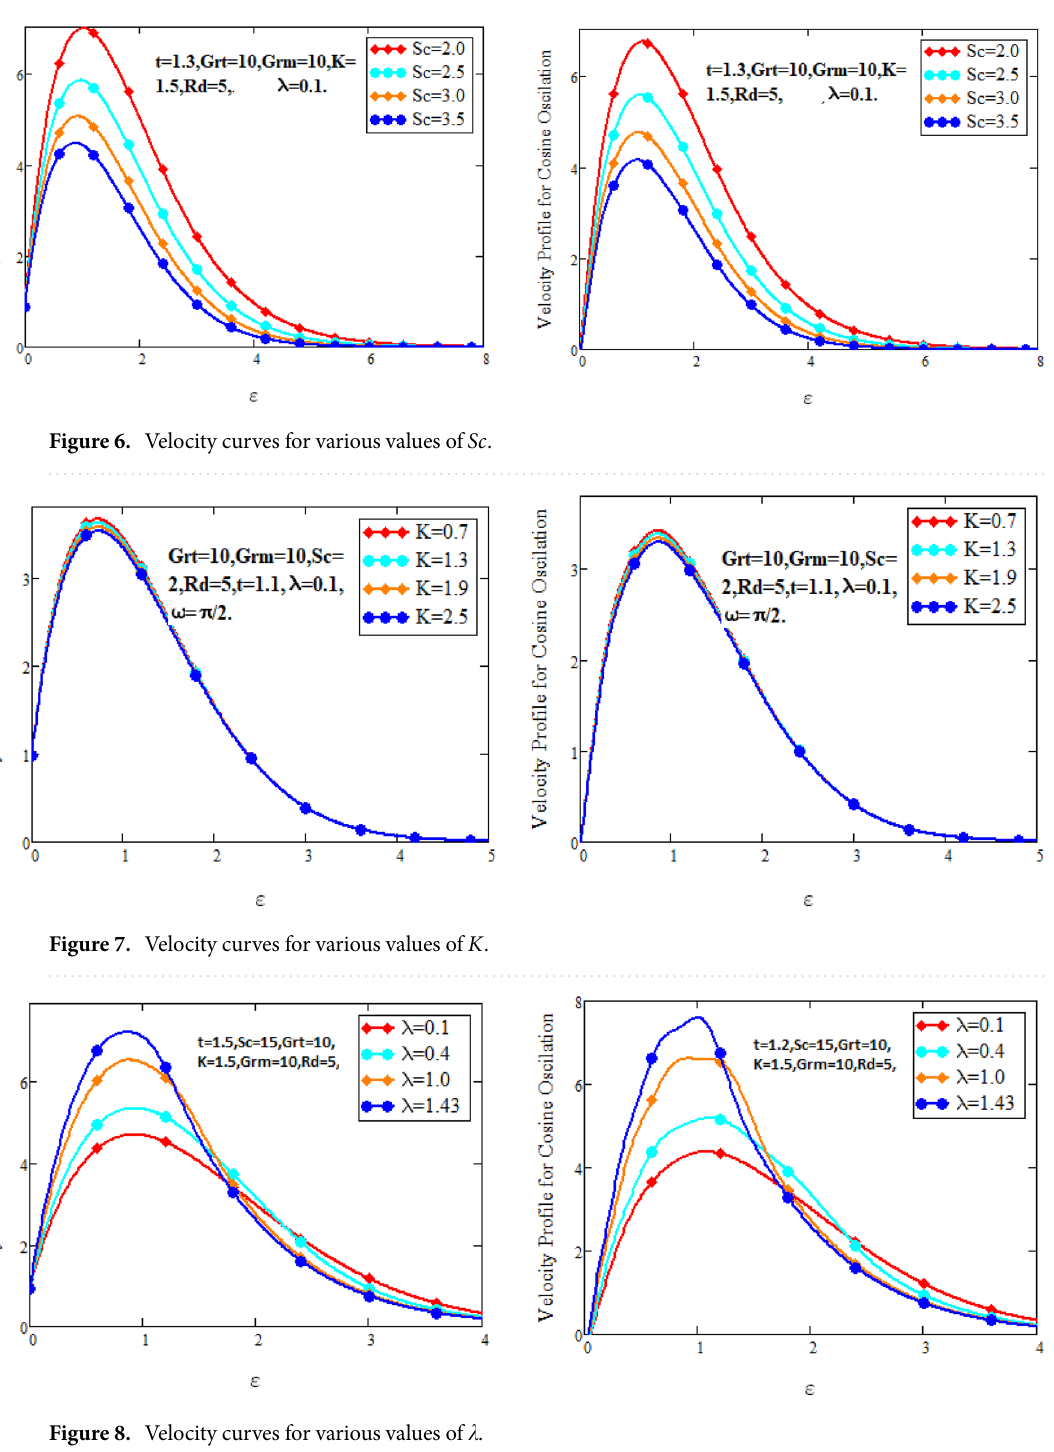
Figure 8. Velocity curves for various values of (cid:31)